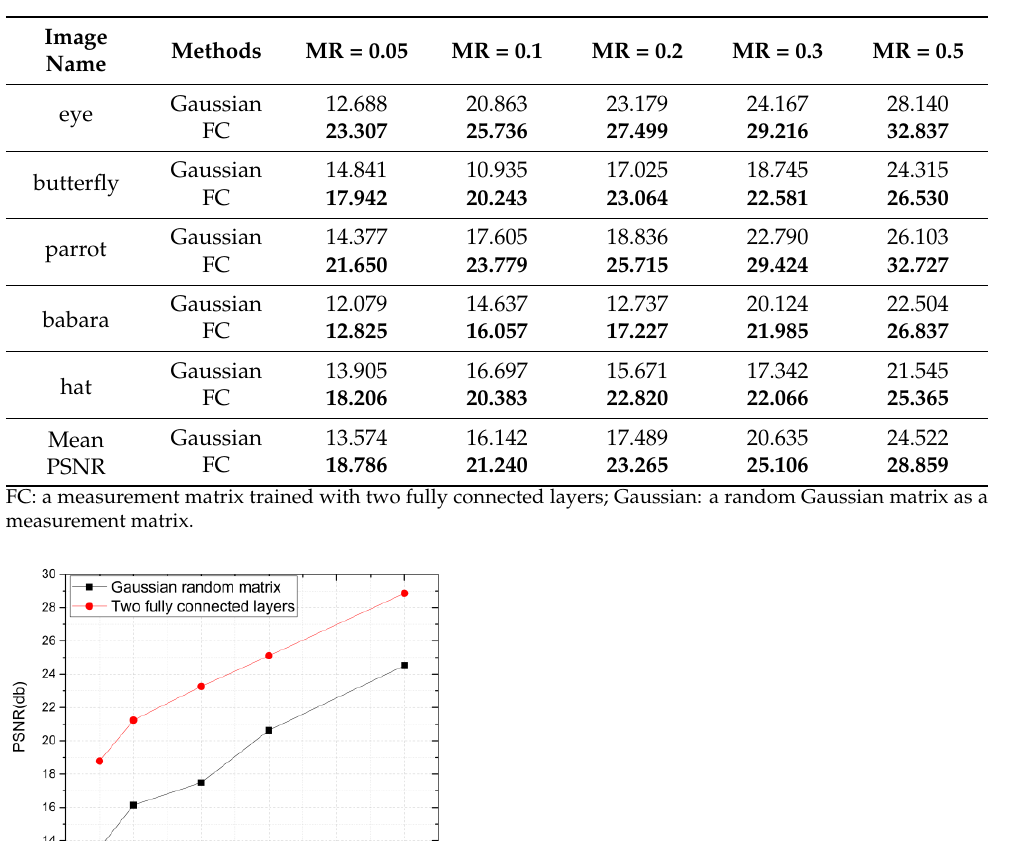
Table 2. PSNR values of DPAP imaging results using different measurement matrices at different measurement rates.